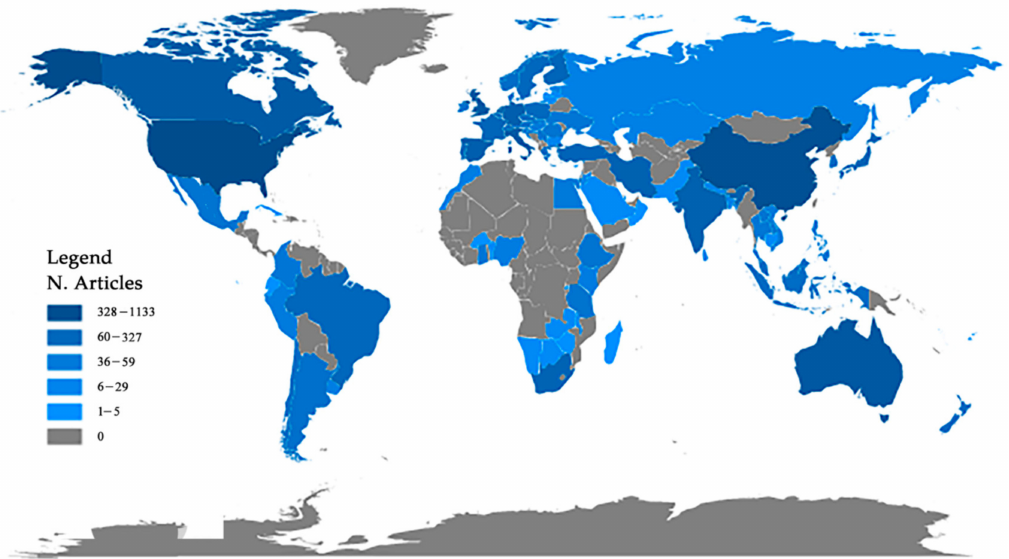
Figure 5. Countries’ scientific production in the field of land use